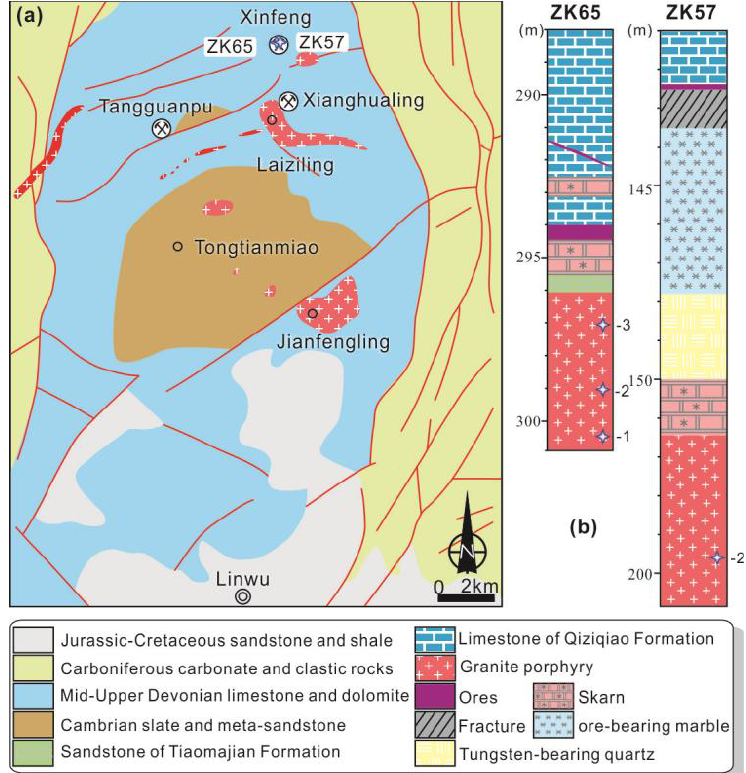
Figure 2. ( a ) The simplified geological map of the Xianghualing Sn-polymetallic deposit, South China [12,53]. ( b ) Drill core profile showing the sample locations.